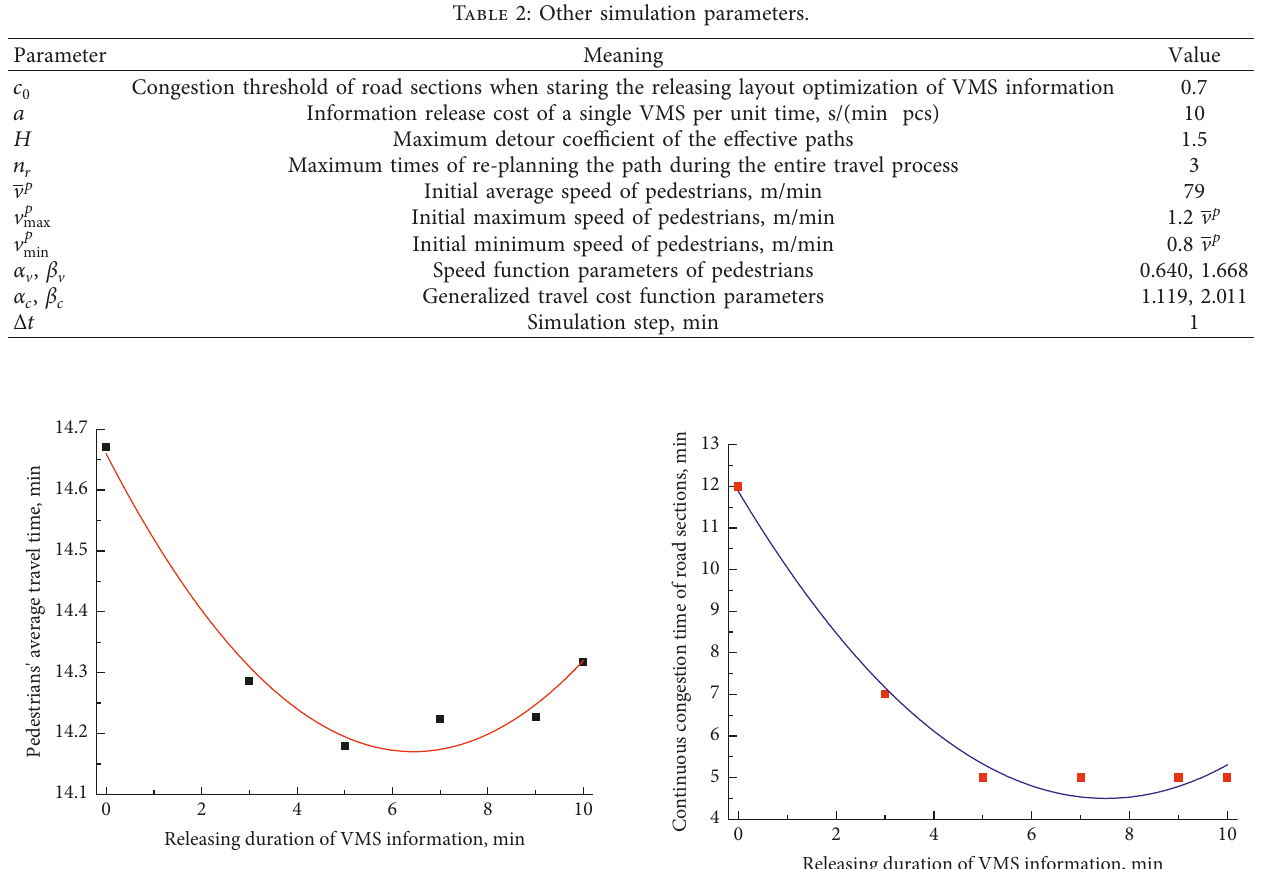
Figure 8: The impact of the releasing duration of VMS information on the pedestrians’ average travel time. Figure 9: The impact of the releasing duration of VMS information on the continuous congestion time of road